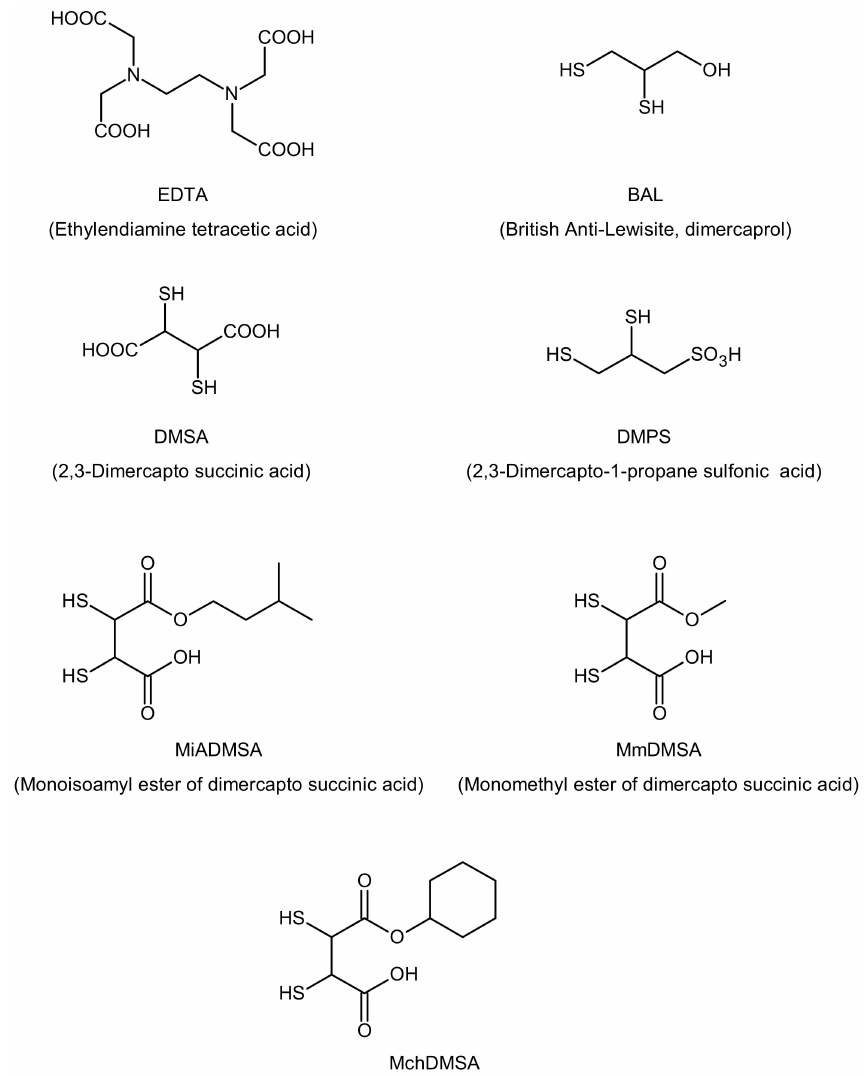
Figure 1. Structures of cadmium chelating